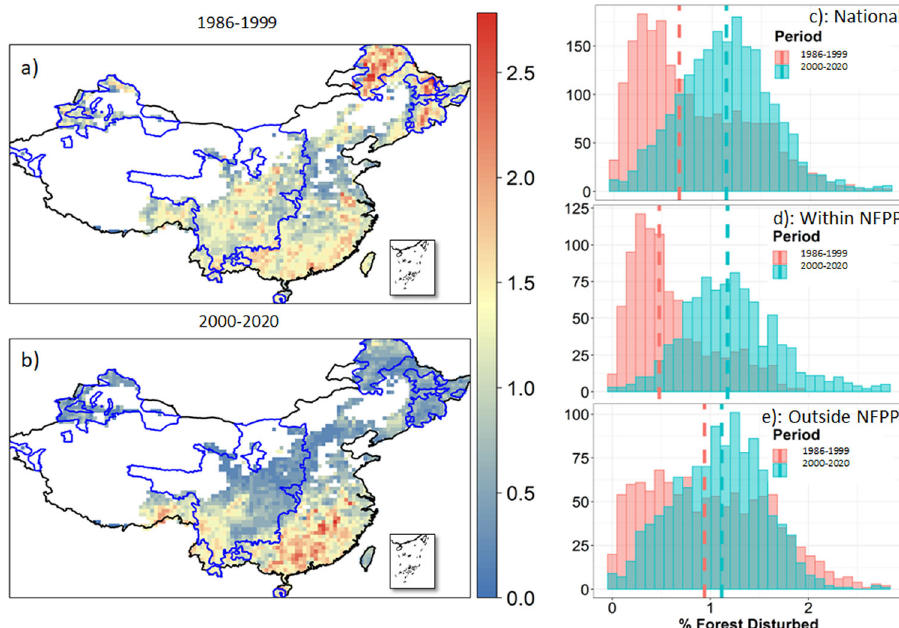
Fig. 5 Signi fi cant decreases in forest disturbance rate due to the implementation of China ’ s National Forest Protection Program (NFPP) in 1999. a , b showed the spatial distribution of percent of disturbed forest annually (% yr − 1 ) within each 0.5° grid cell before ( a , 1986 – 1999) and after ( b , 2000 – 2020) NFPP. c – e showed the histogram distribution of percent of disturbed forest annually (% yr − 1 ) before (blue) and after (red) NFPP at national ( c ), within the NFPP region ( d ), and outside the NFPP region ( e ). Blue lines in a and b indicated the NFPP boundary (also see Supplementary Fig.